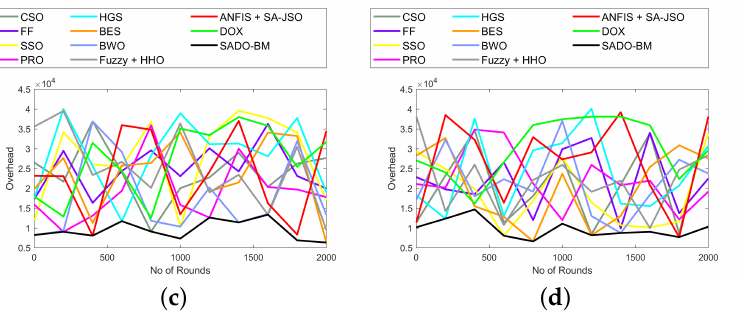
Figure 8. Overhead analysis of SADO-BM over other models for node counts ( a ) 100, ( b ) 250 ( c ) 750, and ( d ) 1000.